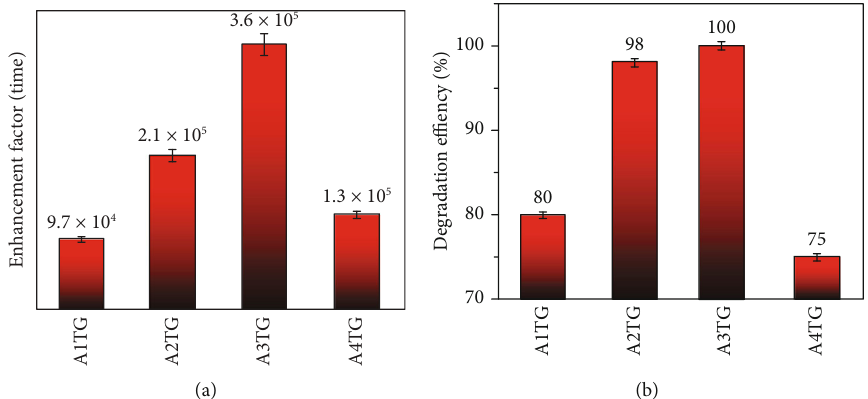
Figure 5: Comparison of enhancement factor (at 10 -6 M) (a) and degradation e ffi ciency (b) of Ag/TiO